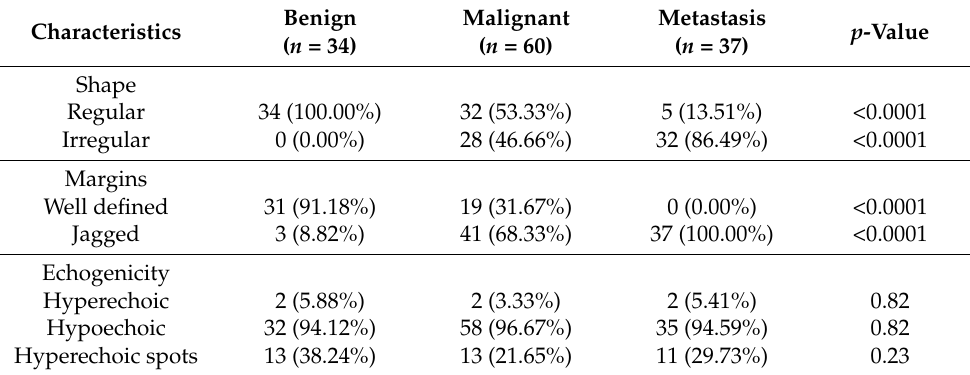
Figure 2. ( a ) Intraoperative lung ultrasound (ILU) scan showing a hyperechoic pulmonary nodule (white arrow) with a regular rounded shape and well-defined margin. The final histological diagnosis was pulmonary hamartoma. ( b ) Intraoperative lung ultrasound (ILU) scan showing a hypoechoic nodule (blue arrow) with irregular shape and jagged margin. The final histological diagnosis was pulmonary adenocarcinoma. Table 3. Ultrasound characteristics of nodules examined using ILU and their relationship to their pathologic nature.